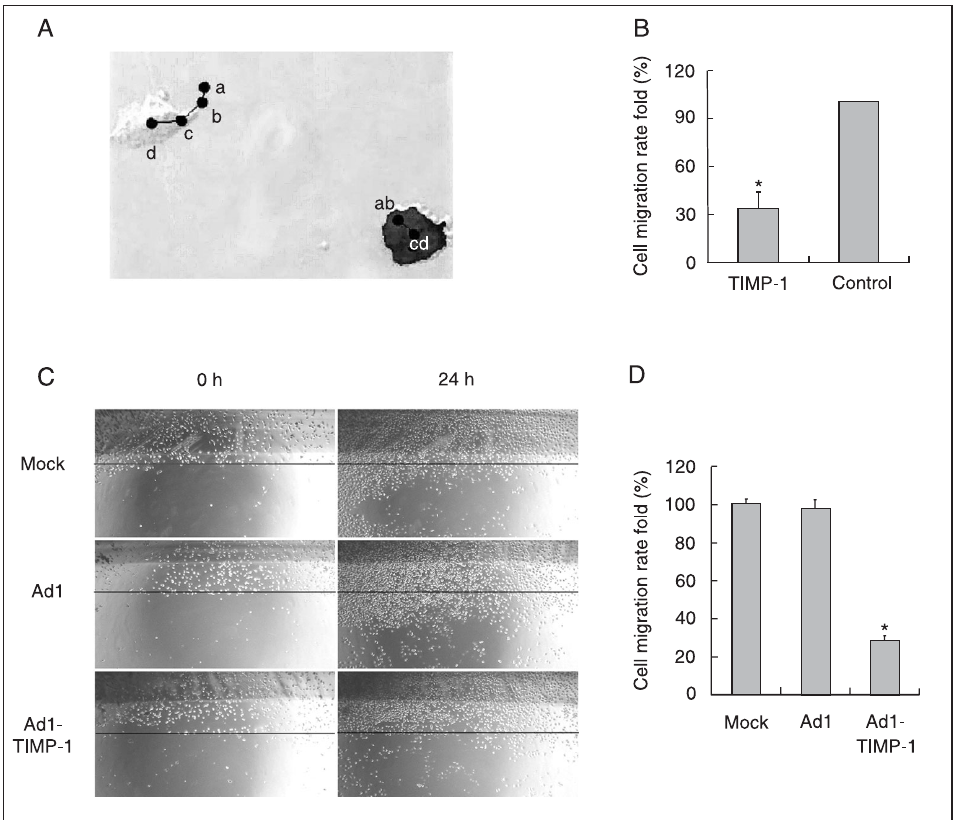
Figure 5. Inhibitory effect of tis- sue inhibitor of metalloprotein- ases (TIMP-1) on the migration of BEL-7402 cells. A , The cen- ters of cells monitored every hour are shown by a, b, c, d. The cell on the right overexpressed TIMP-1. B , The relative average velocity of single cell migration was calculated for TIMP-1-trans- fected and control cells. C , Abil- ity to migrate affected by TIMP-1 using a wounding assay. Con- fluent monolayers of three groups of BEL-7402 cells were scraped using a tip and then cultured for 24 h. The cells were photo- graphed and the migration dis- tance was determined. The bee- line indicated the same location. D , The migration distance of three groups was determined. *P < 0.01 for 7402/Ad1-TIMP-1 compared with the 7402/Ad1 group (Student t